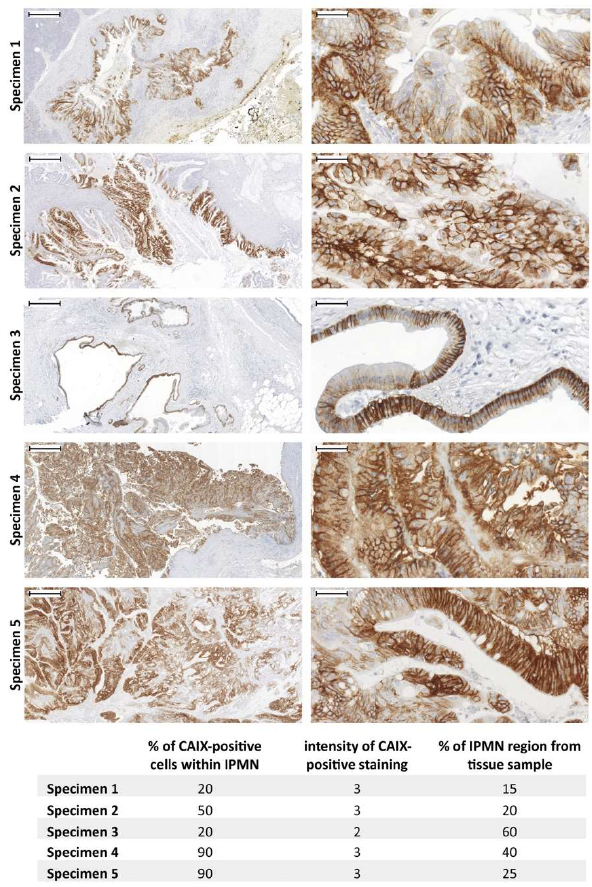
Figure 6. Immunohistochemical staining of CAIX in IPMN lesions within pancreatic ductal adenocarcinoma (PDAC) patient samples. The set of 5 IPMN tissue specimens were immunostained using the specific anti-CAIX monoclonal antibody M75 [143] as described previously [144] . Representative pictures taken from all 5 IPMN tissue specimens (left side) were complemented with detailed pictures (right side) describing CAIX-specific staining pattern (brown). All sections were counterstained with Mayer’s hematoxylin (blue nuclei). Scale bar 500 μm (left side) and 50 μm (right side). Using a large-scale profiling of gene expression among 12 intraductal papillary mucinous neoplasms with and without associated invasive carcinoma, Sato et al. identified a panel of genes significantly upregulated (fold change of 5 or more) in IPMN in comparison to healthy tissue samples and genes potentially linked to an invasive phenotype of IPMN [139]. Interestingly, multiple genes found among the most highly upregulated ones in IPMNs have been already reported as overexpressed in PDAC. Our in silico analysis of the GSE19650 dataset revealed that CA9 displays a high positive correlation with several of these genes (Figure 7), such as S100P (correlation coefficient 0.67), mesothelin MSLN (0.82), prostate stem cell antigen (PSCA) (0.82) and, to a lesser extent, with CD55 (0.46), TPM2 (0.35), and SERPINB5 (0.29). CA9 expression was also linked to glycolysis-related gene HK2 and genes coding proteins involved in pH regulation (anion exchanger 2 (AE2), sodium/hydrogen exchanger 1 (NHE1)).